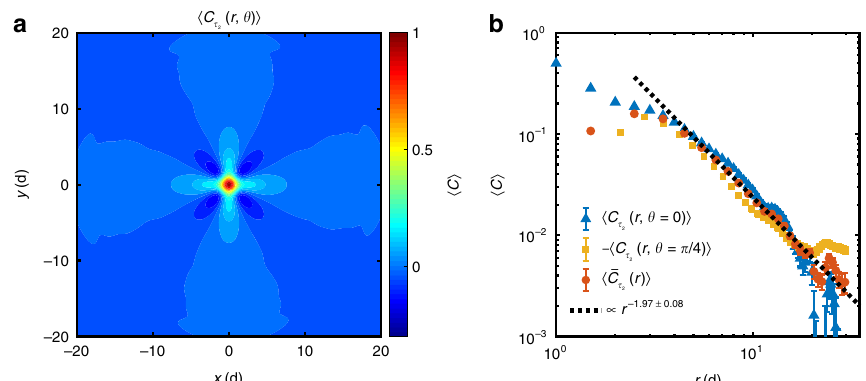
ð r ; θ Þi of coarse-grained shear stress τ 2 ð r ; θ Þi along θ = 0 and θ = π /4, and their azimuthal averaged 2